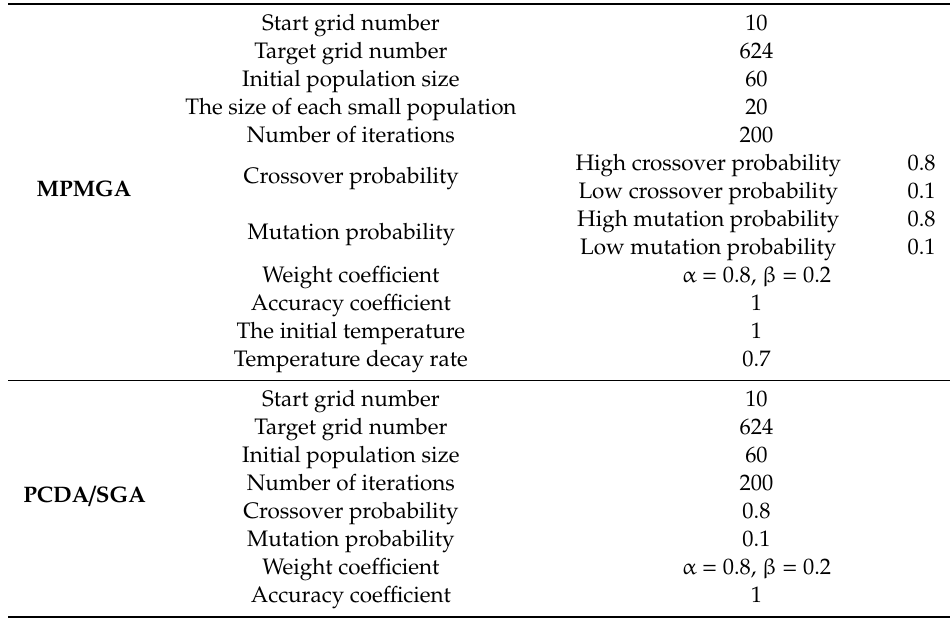
Table 2. Algorithm Table 2. Algorithm parameters.